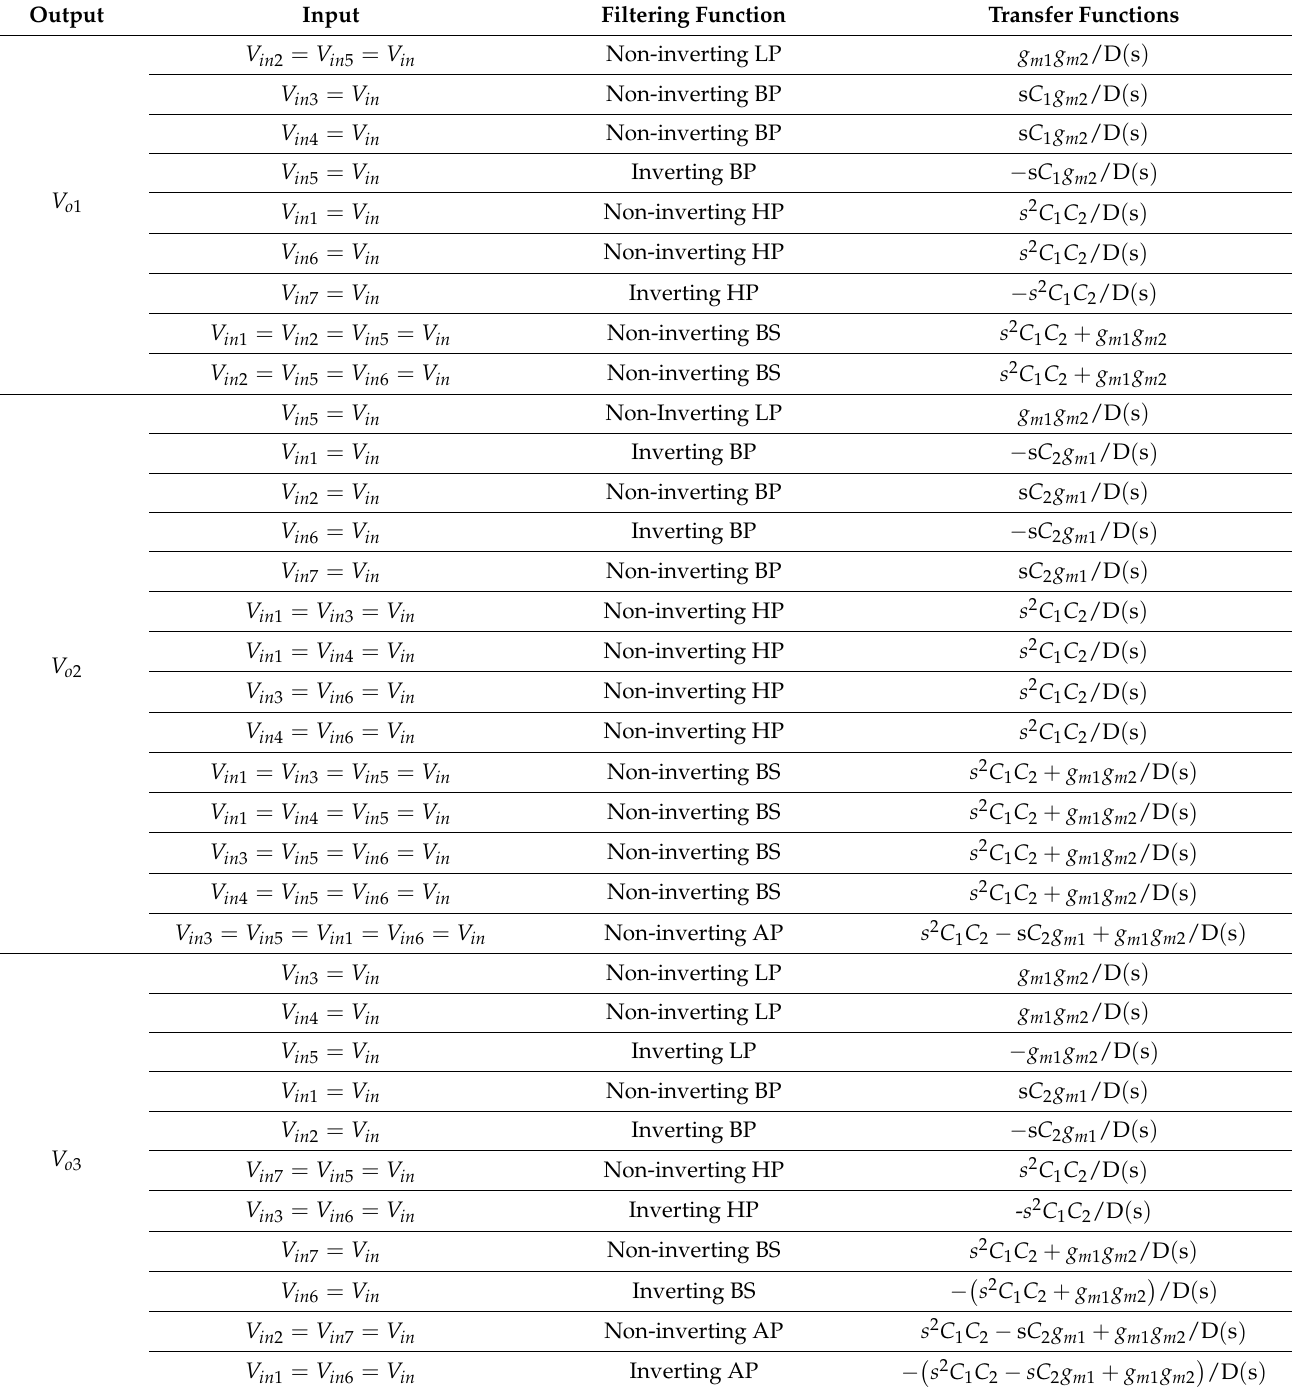
Table 1. Obtaining variant filtering function of voltage-mode analog